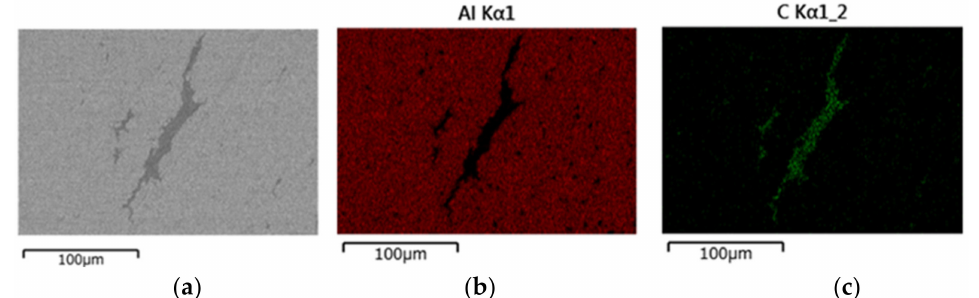
Figure 3. Cross-sectional scanning electron microscope (SEM) image ( a ) and energy dispersive x-ray spectrometry (EDX) mapping results (Al ( b ) and C ( c )) focusing on CNT aggregation in CNT / Al composites (ultrasonic treatment for 1 h, CNT content of 1.0 mass.%).